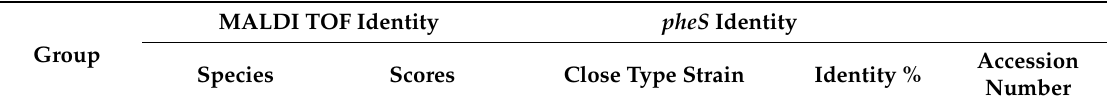
Table 1. Results of identification of isolated strains by MALDI-TOF MS and pheS gene sequencing. In bold, selected strain for each group to sequence the pheS